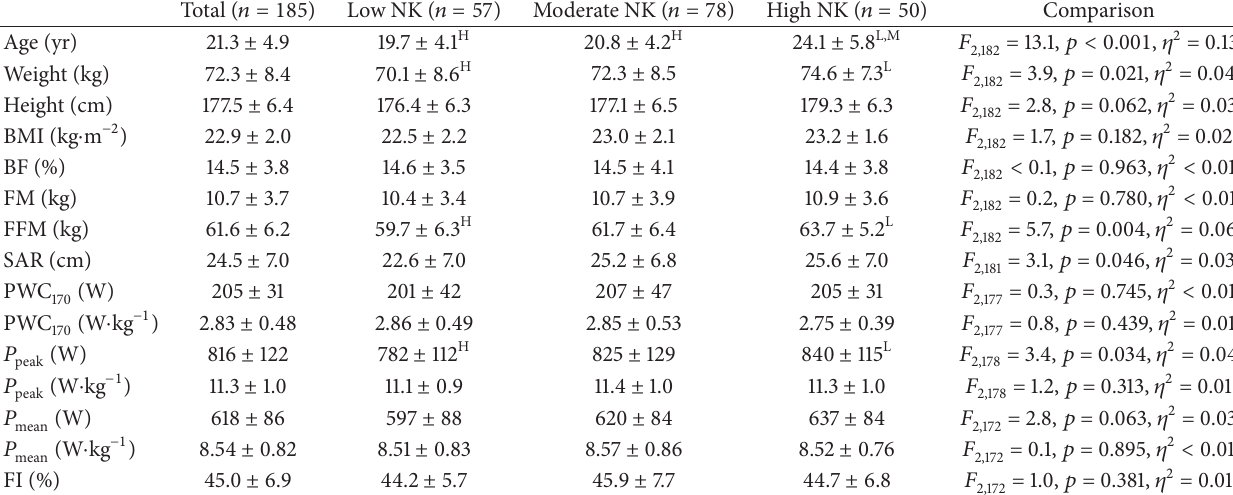
Table 2: Anthropometry, body composition, flexibility, and aerobic and anaerobic power of soccer players by nutritional